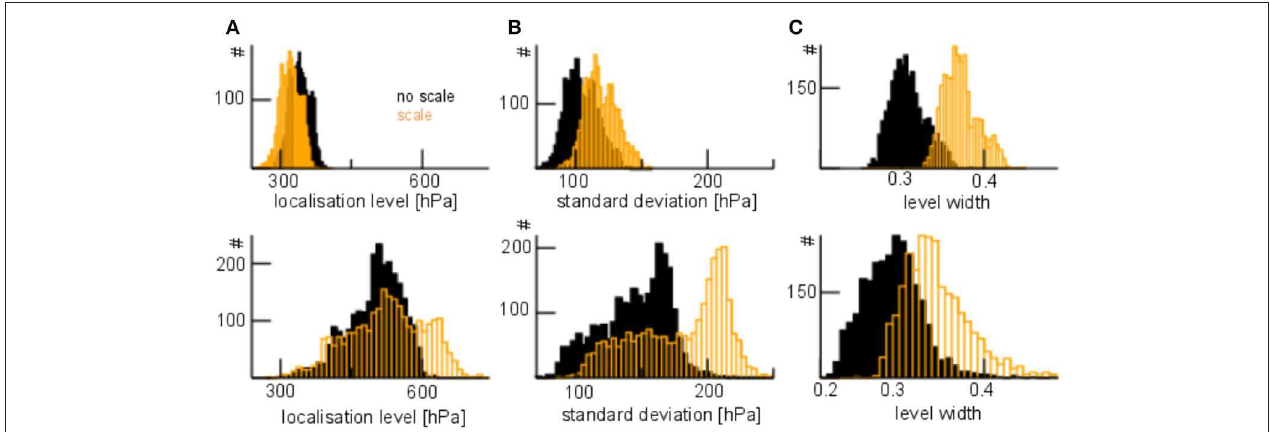
FIGURE 4 | Effect of pressure layer scaling on localization level p 0 (A) , on the standard deviation of the sensitivity function σ (B) and the relative level width l = σ/ p 0 (C) . Top panel: channel 6.2 µ m. Bottom panel: channel 7.3 µ m. Data are taken over the COSMO-DE domain and the summer period from May 26, 00 UTC to May 31, 23 UTC in 2016.